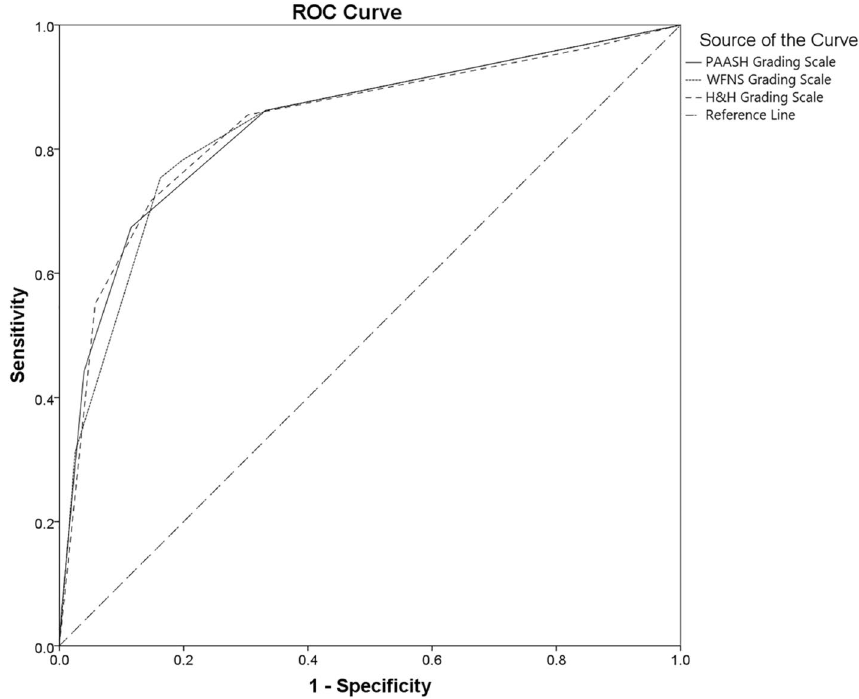
Figure 2. The overall prognostic performance of the SAH grading scales for the poor outcomes on day 30th after ictus: The area under the ROC curves of the PAASH (AUROC: 0.840 [95% CI 0.796–0.883]; cut-off value: ≥ 2.5; sensitivity: 67.4%; specificity: 88.4%; P AUROC < 0.001), the WFNS (AUROC: 0.836 [95% CI 0.793–0.880]; cut-off value: ≥ 3.5; sensitivity: 75.4%; specificity: 83.8%; P AUROC < 0.001), and the H&H scales (AUROC: 0.839 (95% CI 0.795–0.883); cut-off value: ≥ 3.5; sensitivity: 71.7%; specificity: 85.2%; P AUROC < 0.001) for predicting the poor outcomes on day 30th after ictus in patients with aneurysmal SAH ( AUROC areas under the receiver operating characteristic curve, H&H Hunt and Hess, PAASH prognosis on admission of aneurysmal subarachnoid haemorrhage, poor outcome defined as a modified Rankin Scale [mRS] score of 4–6, ROC receiver operating characteristic, SAH subarachnoid haemorrhage, WFNS World Federation of Neurological